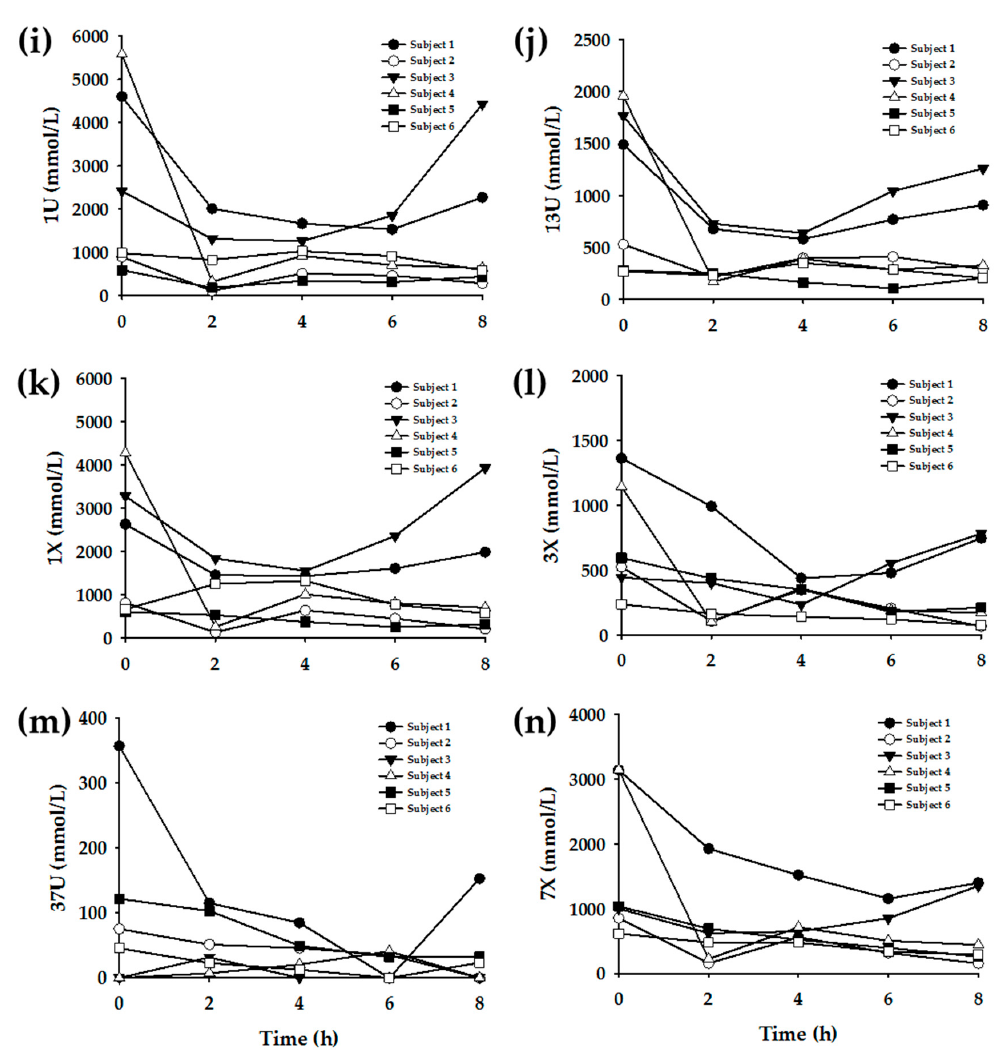
Figure 2. Urinary concentration levels of caffeine and its metabolites in six subjects. ( a ) caffeine, ( b ) 1,3,7-trimethyluric acid (137U), ( c ) 1,3-dimethylxanthine (13X), ( d ) 1,7-dimethylxanthine (17X), ( e ) 3,7-dimethylxanthine